Question: State the chart type depicted above.
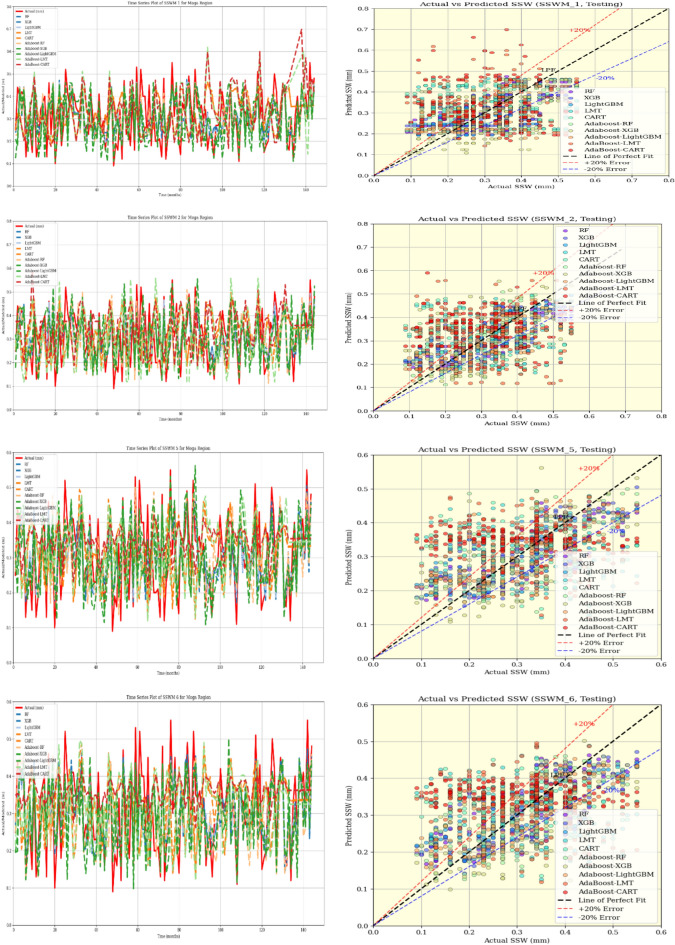
Answer: scatter